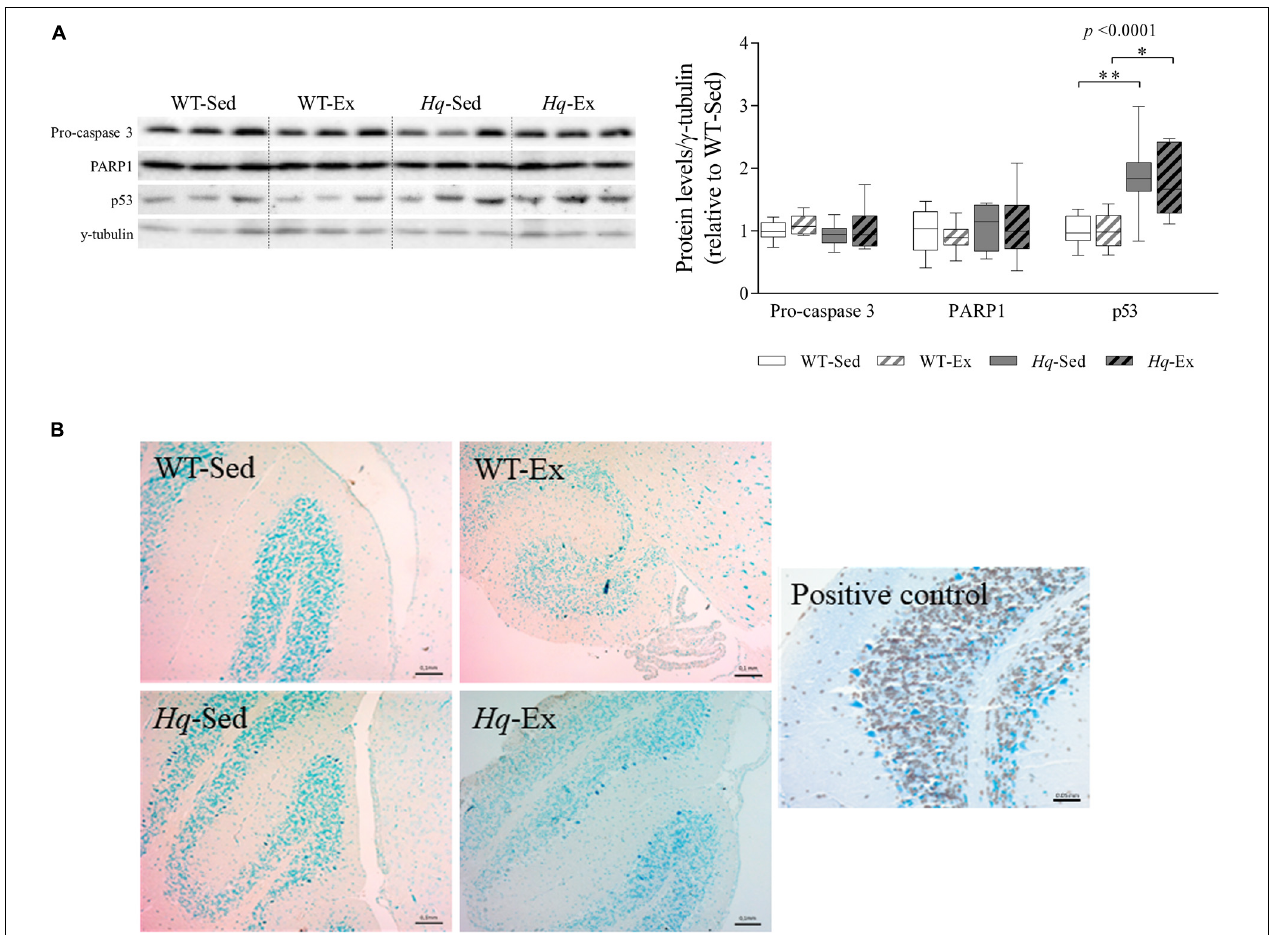
FIGURE 4 | Apoptosis markers. (A) Western blot analysis of pro-caspase 3, poly [ADP-ribose] polymerase 1 (PARP1) and p53 in cerebellum homogenates of wild-type sedentary (WT-Sed, n = 12) and exercise-trained (WT-Ex, n = 11) mice, and of Hq sedentary ( Hq -Sed, n = 11) and exercise-trained ( Hq -Ex, n = 10) mice. Densitometry analysis: protein levels were normalized to γ -tubulin levels; data (median, interquartile range, and min and max values) are expressed relative to levels in the WT-Sed group. Significant p- values for the group effect (Kruskal-Wallis test) are shown above the corresponding boxes. Symbols for significant differences in post hoc pairwise comparisons: ∗ p < 0.05; ∗∗ p < 0.01 for Hq -Sed vs. WT-Sed, and Hq -Ex vs. WT-Ex. (B) Detection of apoptotic nuclei in cerebellar cortex by TUNEL assay, counterstained with hematoxylin (10 × ). DNase-treated samples were used as a positive control. Analyses were performed in 12 WT-Sed, 11 WT-Ex, 11 Hq -Sed and 9 Hq -Ex mice (1 section per